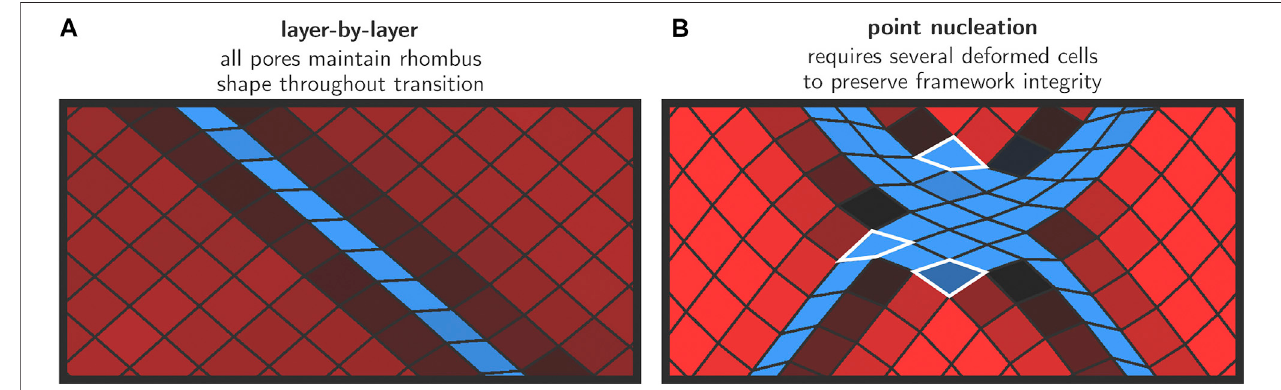
FIGURE5| Snapshotsforthetransitionmechanismsintheinitialgrowthphase.Forthelayer-by-layermechanism (A) ,therhombusshapeispreservedthroughout thetransition.Inthecaseofdiscretenucleationpoints (B) ,largedeformationsarenecessarytopreservetheframeworkintegrity — suchcellsareemphasizedwithawhite border.